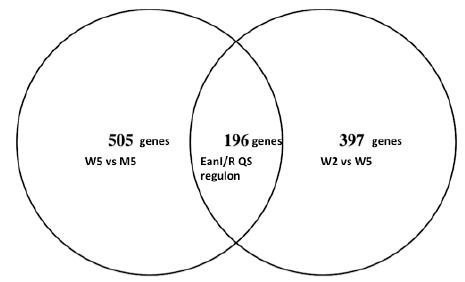
Figure 3. Identification of the EanI/R QS regulon . The genes that were differentially expressed between the sampling points before QS and during QS (W2 versus W5) that were also differentially expressed between the wild type and its QS mutants (M5 versus W5) were considered to be under QS regulation. A total of 196 genes were found to be influenced by EanI/R QS system. The number of genes in W2 versus W5 in the Venn diagram is 593 since 15 genes in W2 versus W5 data set encode for proteins with unknown protein ID. The 15 genes have protein IDs indicated as not available (N/A) in Table S2.